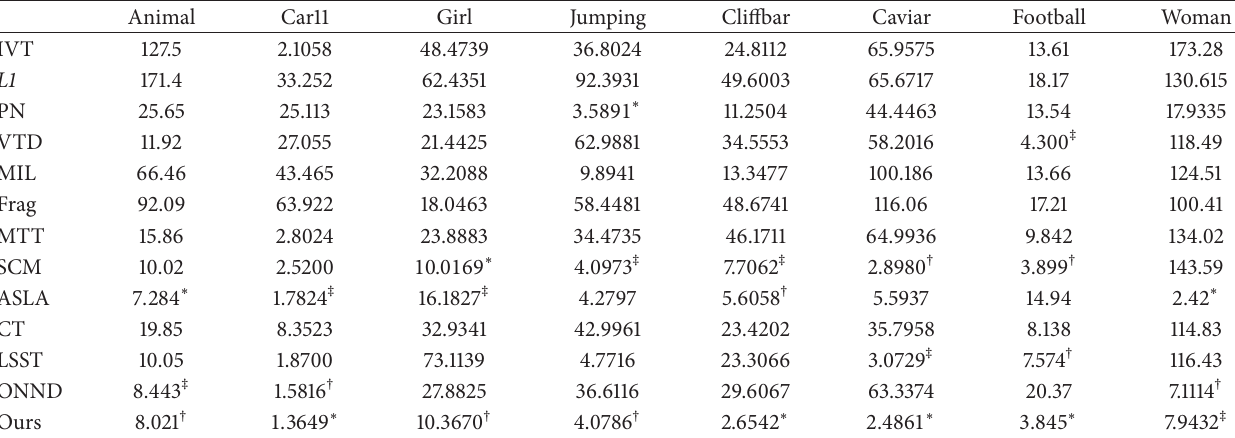
Table 2: Average center location error (in pixel). The best three results are marked by ∗ , † , and ‡ . Animal Car11 Girl Jumping Cliffbar Caviar Football Woman